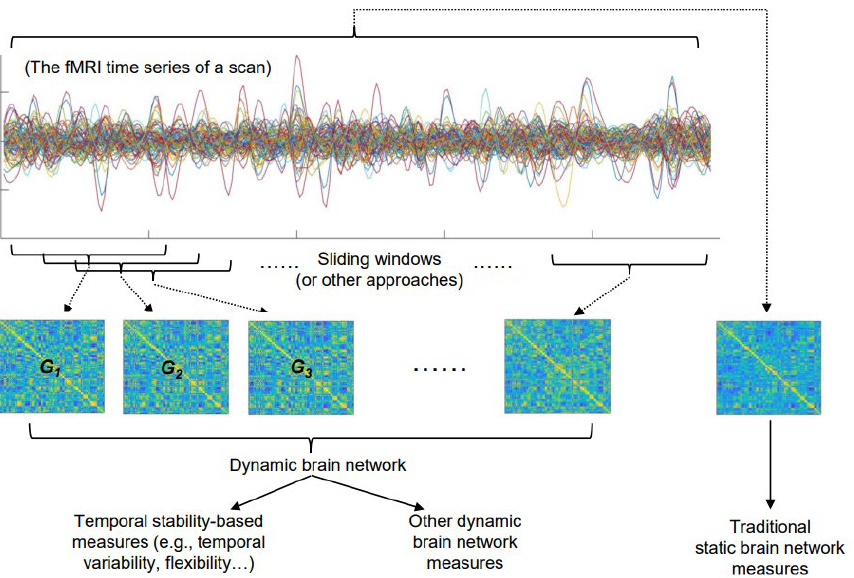
Figure 1. A summary of the steps for constructing dynamic networks and estimating the temporal stability of brain networks, and the relationships between temporal stability and other brain network measures. Note that lines with different colors represent time series of different brain nodes (different brain regions).